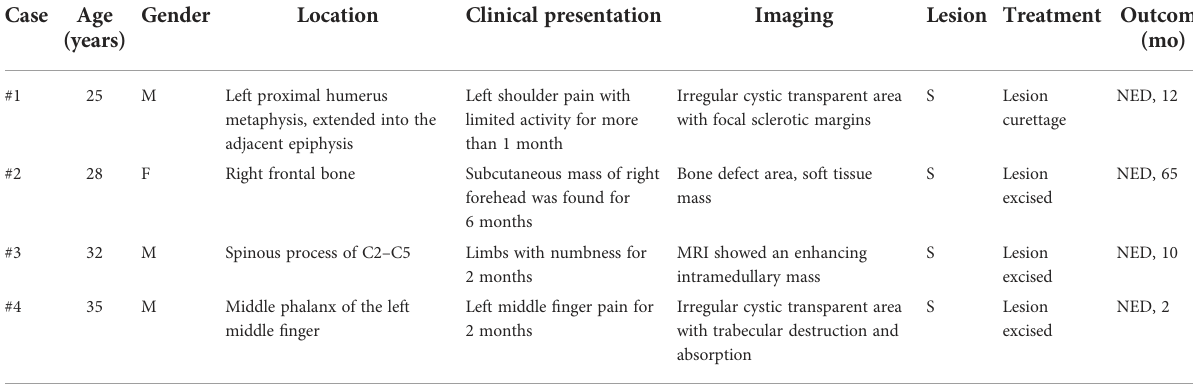
TABLE 1 Clinical features of the four cases of primary intraosseous RDD in our